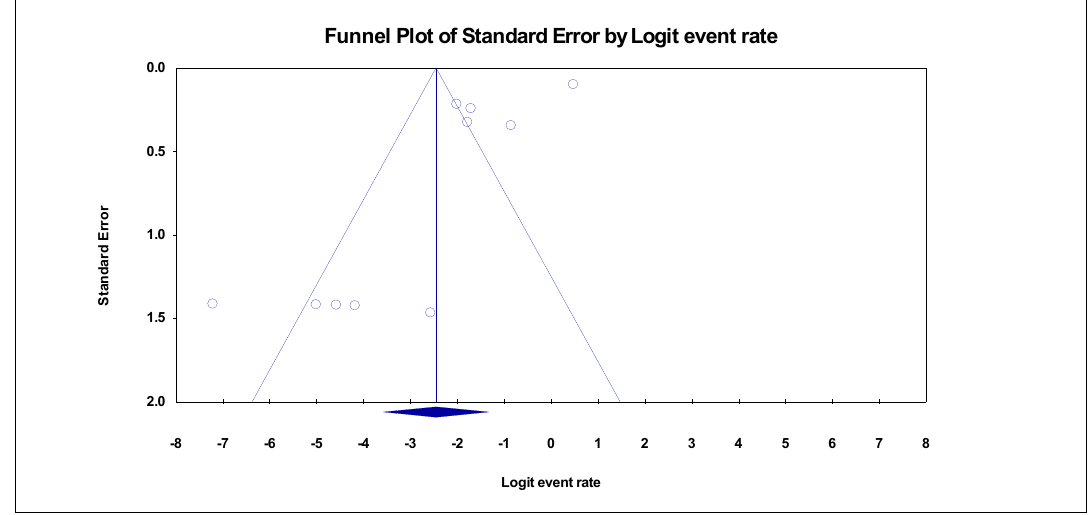
Figure 4. Funnel plot showing publication bias for SBP in HBV cirrhosis (Egger’s p = 0.01273).